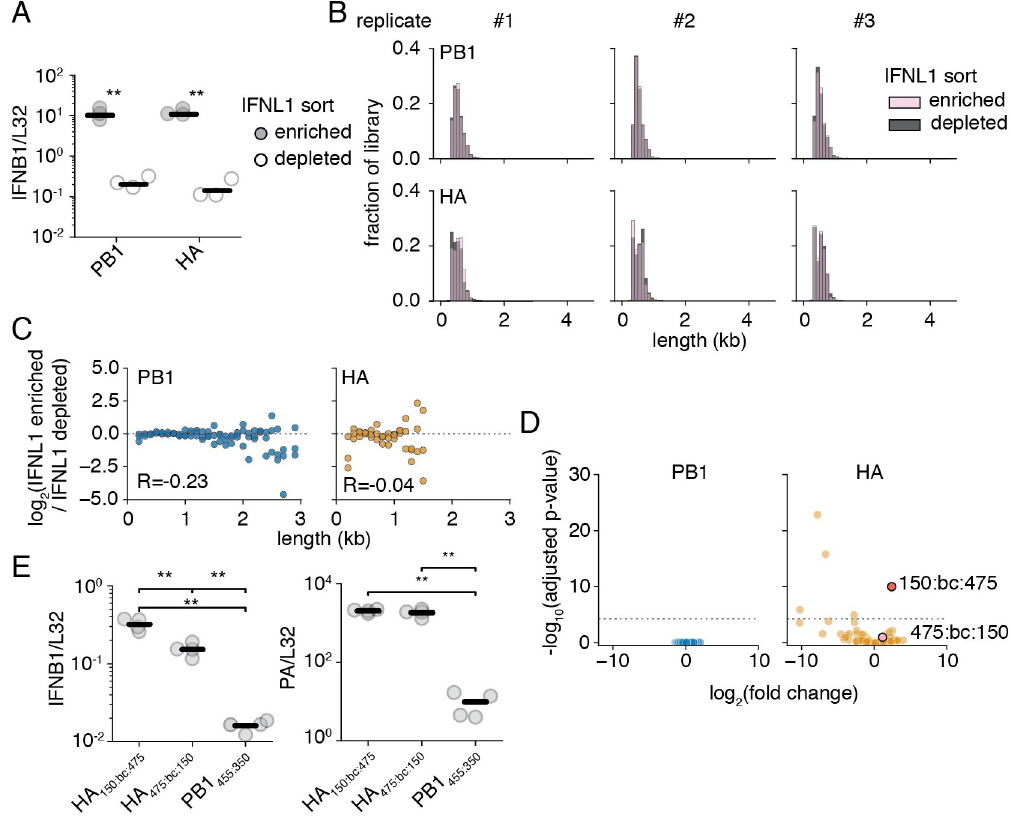
Fig 5. Variant length and interferon induction appear uncorrelated. (A) An A549 type III interferon reporter line was infected at an MOI of 0.05 and sorted using magnetic-activated cell sorting 14 hours post infection. qPCR against the type I interferon, IFNB1 , as corrected by the housekeeping gene L32 . Asterisks indicate significantly increased IFNB1 transcript, two- tailed t-test. n = 3. qPCR of IFNB1 sort performed in Fig 4A for comparison in S14 Fig (B) Size distributions of libraries from the sorting in (A) . (C) Interferon induction and length are not correlated. Each point represents a 100nt bin. The fraction of variants falling within each bin was compared between interferon-enriched, and -depleted selections. Points above the dotted line are co-enriched with interferon. Points were only shown if represented in all three libraries under both conditions. R is the Spearman correlation coefficient. n = 3. (D) Enrichment or depletion of individual variants within libraries. Each individual point represents a distinct 5’ and 3’ junction with < 100 average observations. An adjusted p-value threshold of 0.05 is shown by the dotted line. Variants chosen for further analysis highlighted in red and pink. Full data of differentially enriched variants found in S3 File. (E) Variants of identical length can exhibit different levels of interferon induction. (left) qPCR measuring levels of IFNB1 normalized by L32 in A549 cells infected at an MOI of 0.5 at 14 hours post-infection. (right) qPCR measuring levels of PA to show similar levels of infection between HA variants. Asterisks represent significantly different values in all pairwise comparisons, two-tailed t-test. n = 4. For panels (A) , and (D) , individual points are individual measurements, lines are mean values. For panels (A) , and (D) siginficance was calculated using Benjamini-Hochberg correction at an FDR of